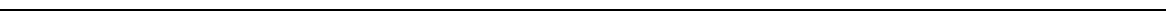
Fig. 2 Proteomic features of the diffuse-type gastric cancer. a Top ranked pathways that are signi fi cantly altered in tumors as compared with nearby tissues. b Signi fi cantly decreased gastric function proteins and gastric mucosa signature proteins in tumors and nearby tissues. The y -axis represents log 10 (FOT) +5. * P < 0.05, ** P < 0.01, *** P < 0.001 (Wilcoxon rank-sum test), Δ Insuf fi cient sample size. c Box plots of log 10 transformed T/N ratios of stomach- speci fi c and not stomach-speci fi c proteins; whiskers show the 1.5-fold IQR, P- value was calculated by Wilcoxon rank-sum test. d Common proteins up- regulated in majority of tumors that were classi fi ed in the four functional categories. (% in parenthesis denotes percentage of tumor samples that exhibit > 3-fold change in 84 patients). e Altered proteins in the WNT, NOTCH, TGF, and INF pathways. Differentially expressed proteins in tumors (T/N > 3) were boxed with red color. The number in parenthesis is the percentage of samples with overexpression when the protein was